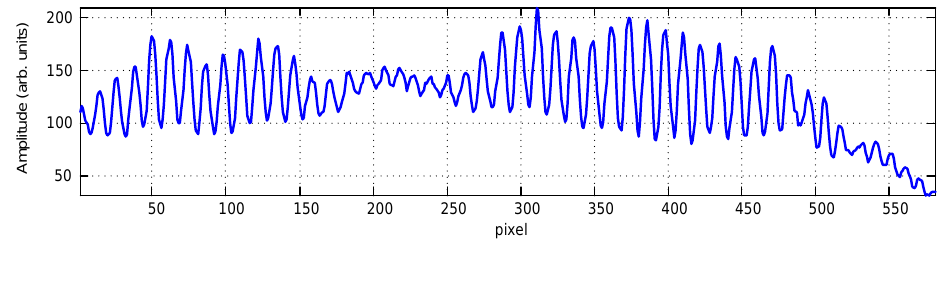
Figure 10. Detail of the 4096-point Fourier Transform of the signal in Figure 9. Two peaks at indexes 331 and 343 appear clearly (courtesy of